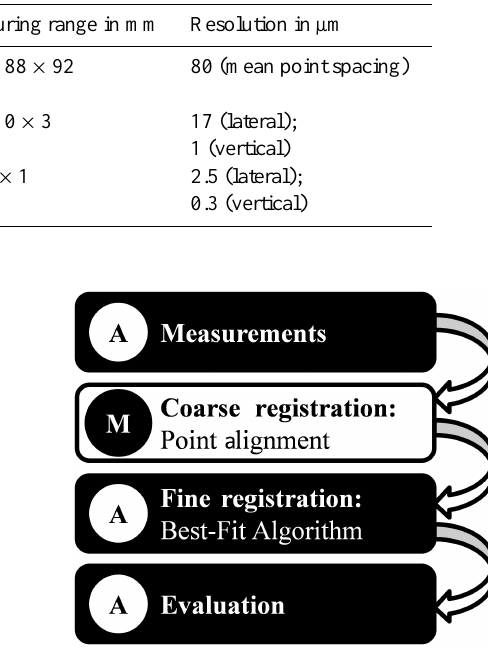
Figure 2. Automatic (A) and manual (M) steps of the standard mea- suring